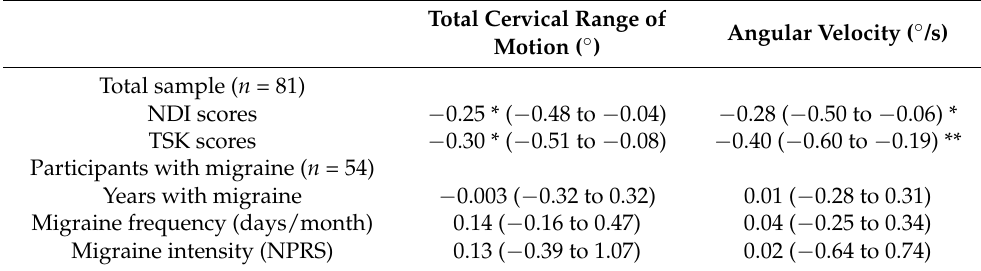
Table 3. Pearson’s correlations (r) and 95% confidence intervals of angular velocity and cervical range of motion angle with both Neck Disability Index (NDI) and Tampa Scale for Kinesiophobia (TSK) scores and with headache